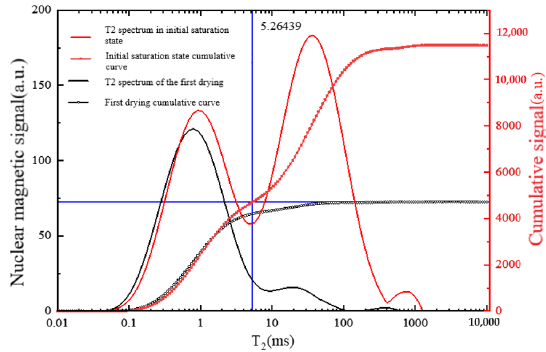
Figure 6. T 2 cutoff calculated by the drying method.